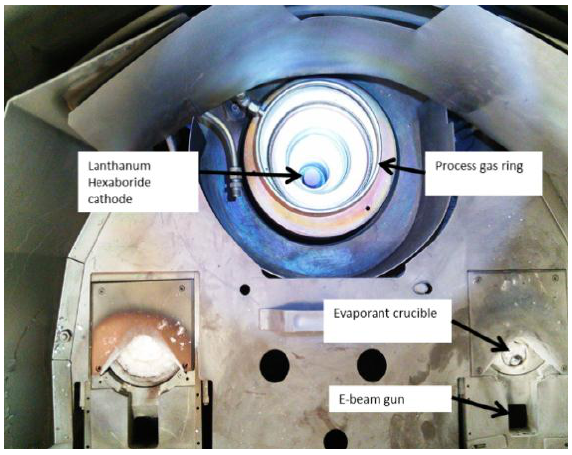
Figure 2. Satis 370 electron beam deposition system baseplate configuration.